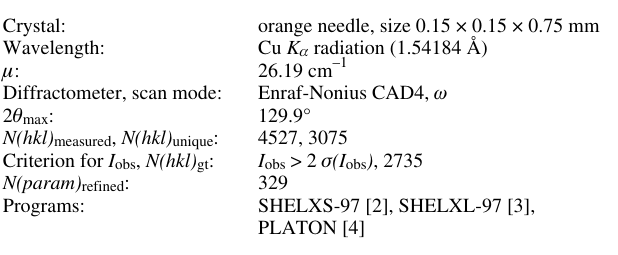
Table 1. Data collection and handling.